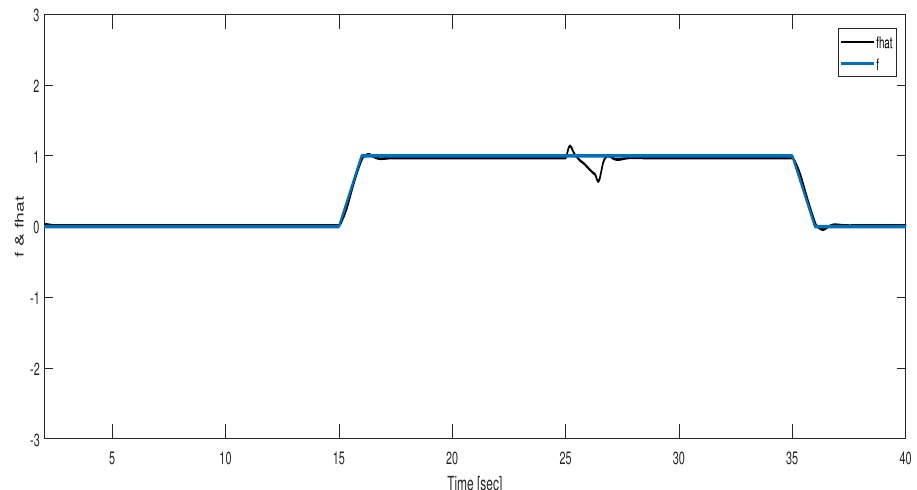
Figure 5. Illustration of robust sensor fault reconstruction (generator speed sensor